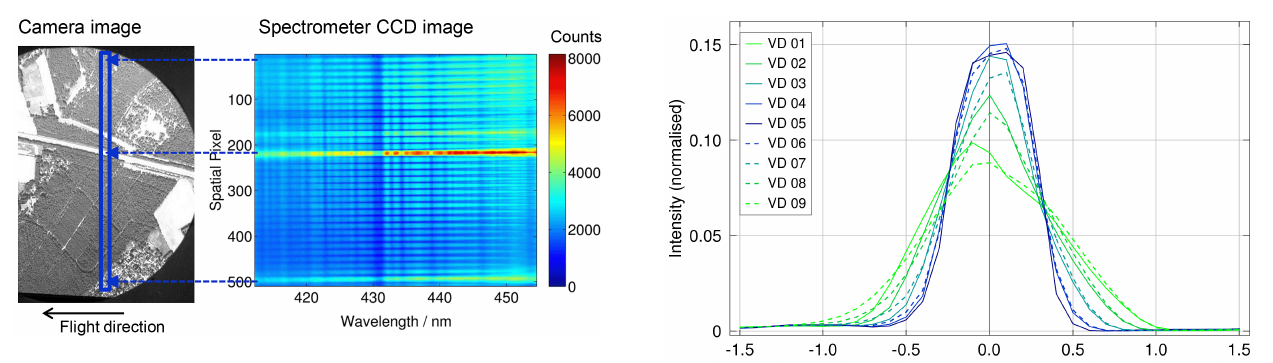
Figure 4. Example scene from a flight along a highly reflecting mo- torway in the centre of the field of view. Left: visual image of the observed scene, the spectrometer field of view marked by the blue box. Right: intensity recording on the 2-D CCD chip, with spectral information distributed along the horizontal axis and spatial infor- mation on the vertical axis. The horizontal stripes on the CCD im- age are caused by the 35 light fibres, the enhanced intensity from the bright motorway being visible only in one of the fibres.